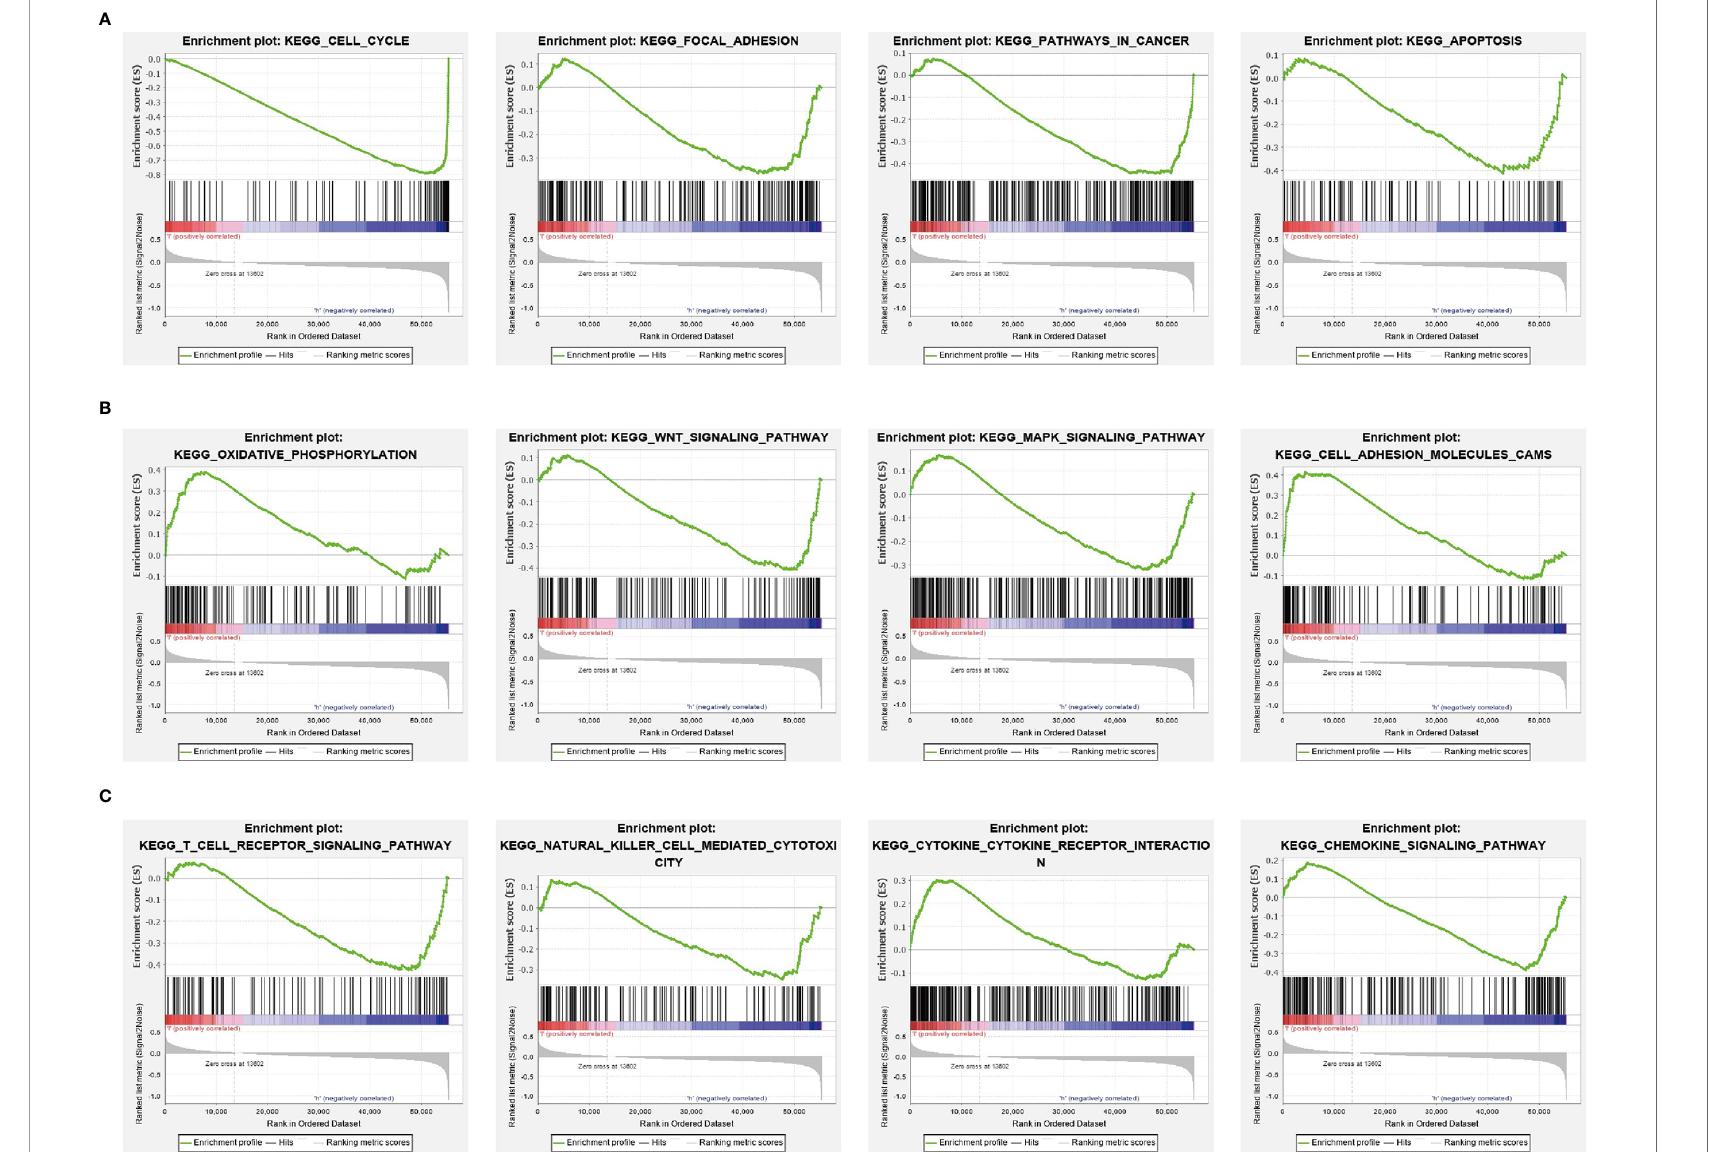
FIGURE 7 | GSEA Identi fi cation of SGO1-related signaling pathways. (A – C) Identi fi cation of SGO1-related signaling pathways by GSEA